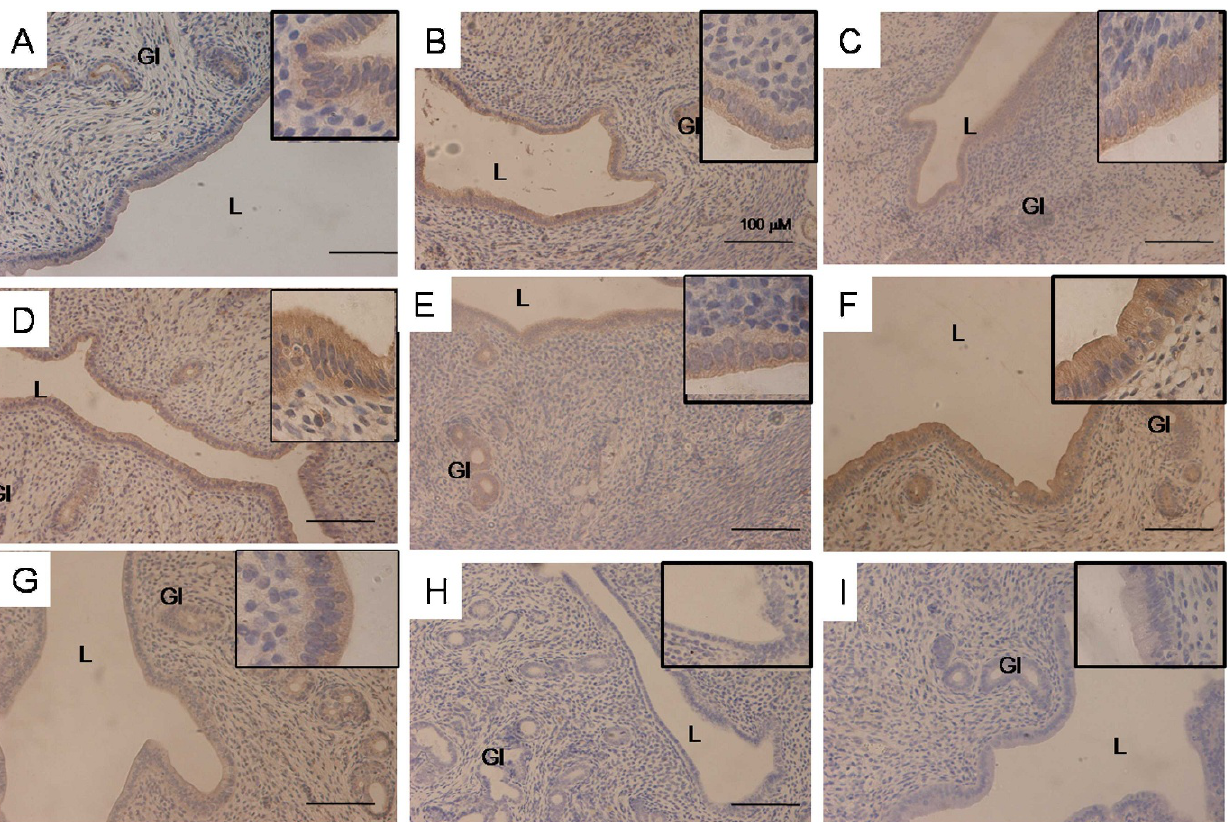
Figure 2 - Representative images of the uterine glandular and luminal epithelium under 20X magnification and the luminal epithelium under 100X magnification (in the upper right-hand corner) from ovariectomised SD rats treated with (A) control (vehicle-treated) (B) 25G (25 mg/kg/day genistein), (C) 25G (25 mg/kg/day genistein) + ICI 182780, (D) 50G (50 mg/kg/day), (E) 50G (50 mg/kg/day genistein) + ICI 182780, (F) 100G (100 mg/kg/day genistein), (G) 100G (100 mg/kg/day genistein) + ICI 182780, or (H) ICI 182780 (100 m g/kg/day) only for 3 consecutive days or (I) incubation with a non-immune peptide. There was a clear increase in the intensity of immunostaining in the group treated with 100 mg/kg/day genistein. L- uterine lumen, Gl– uterine gland, G-genistein. Sections were stained with H&E for nuclear staining; n=6 per